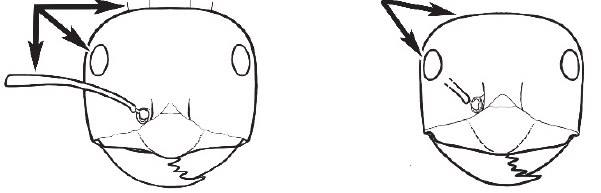
Minor worker concolorous blackish-brown, finely shagreenate with a dull silky sheen; in profile, pronotum rises gradually to its junction with mesonotum without any obvious convexity, while mesonotum is slightly humped; mesosoma with a few to many short, straight, bristly setae, these often expanded distally, length of longest setae ≤ greatest length of antennal scape; appressed setae short, inconspicuous; major worker and media worker concolorous brown (orange-yellow with brown gaster in holotype), with scattered short, sometimes modified setae; appressed setae on gaster well- separated and do not overlap (mainly semi-arid) (Fig. 55a–g) ............... fieldi